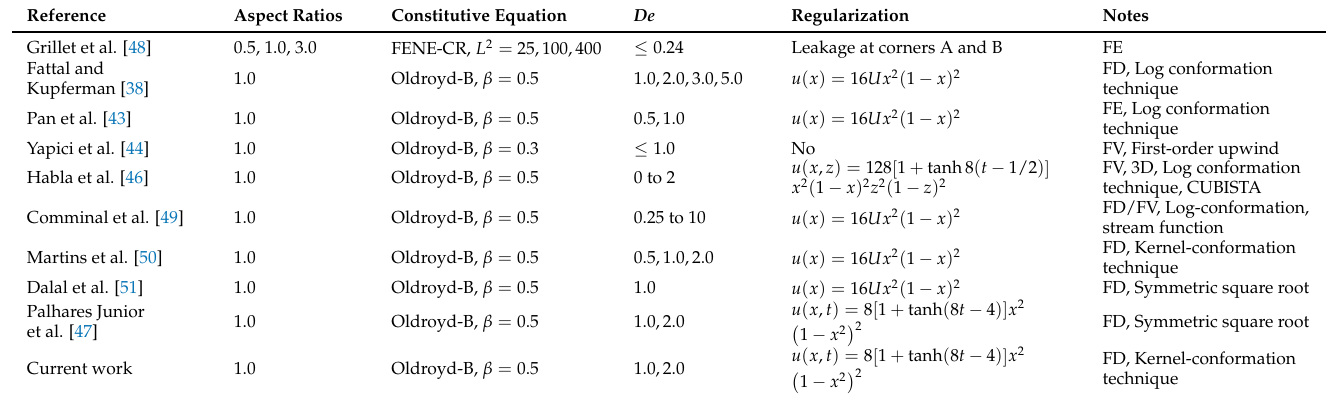
Table 1. Previous and current numerical studies concerned with lid-driven cavity flow of constant viscosity viscoelastic fluids. Reference